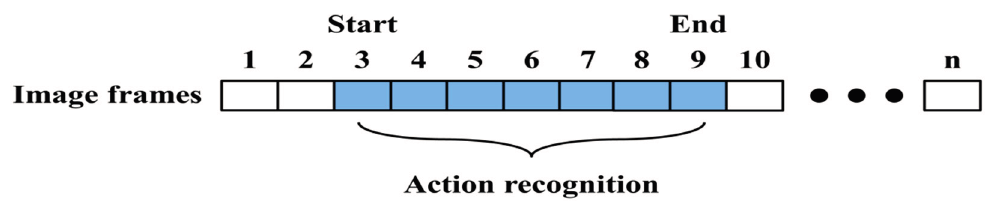
Figure 12. Action recognition for start and end points of image